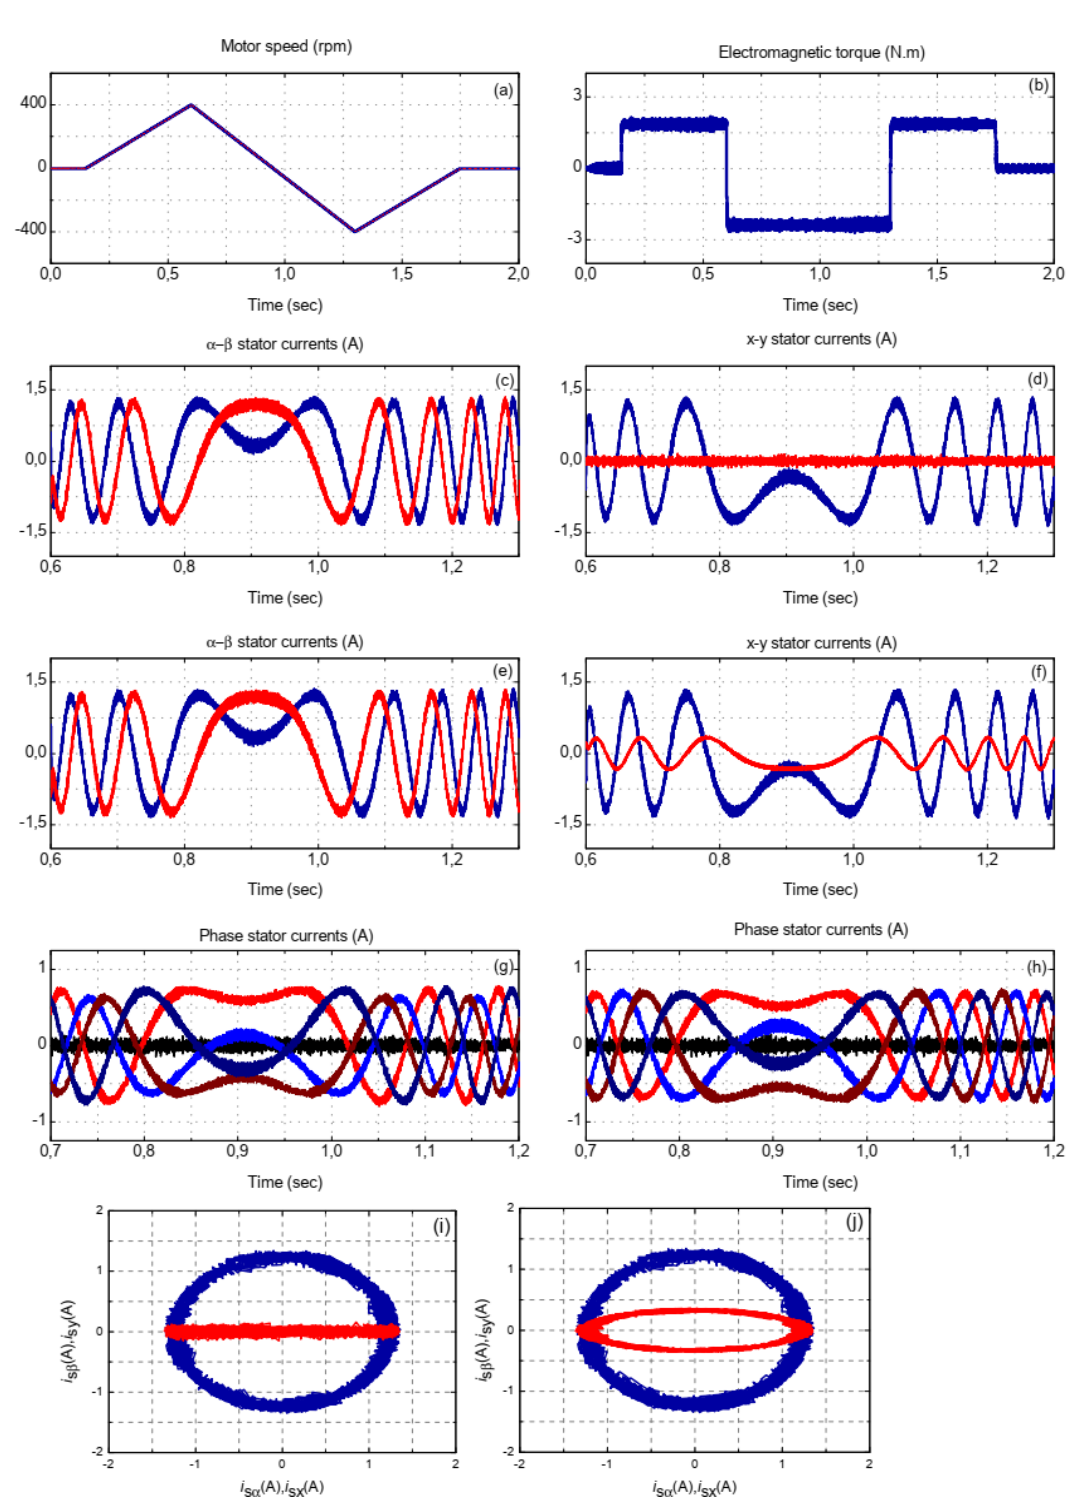
Figure 10. Simulation results of DTC control ( a ) motor speed, ( b ) Electromagnetic torque, ( c ) α – β stator currents ML, ( d ) x – y stator currents ML, ( e ) α – β stator currents MD, ( f ) α – β stator currents MD, ( g ) phase stator currents ML, ( h ) phase stator currents MD, ( i ) current trajectories in the α–β plane ML, ( j ) current trajectories in the x – y plane MD.